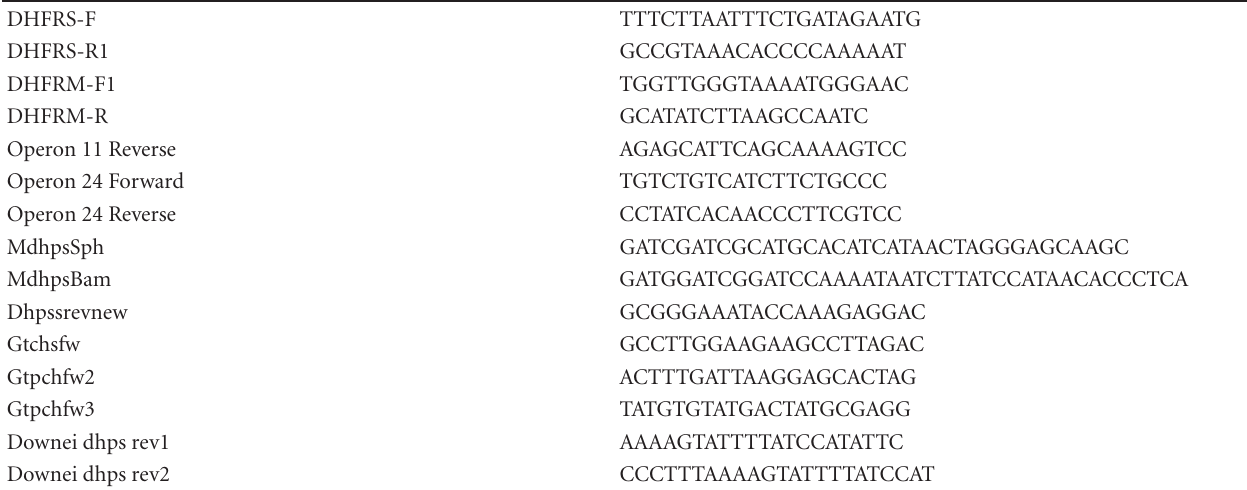
Table 1: Primers